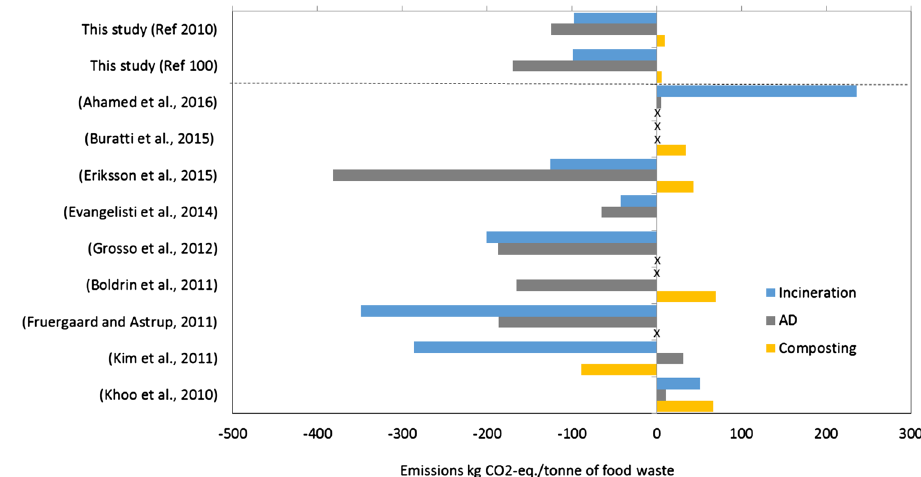
Fig. 5 Results of ten LCA